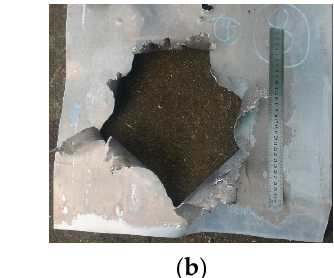
( d ) Figure 13. Damage on the front side of the aluminum target plate: ( a ) No. 3, ( b ) No. 4, ( c ) No. 5, and ( d ) No. 8.